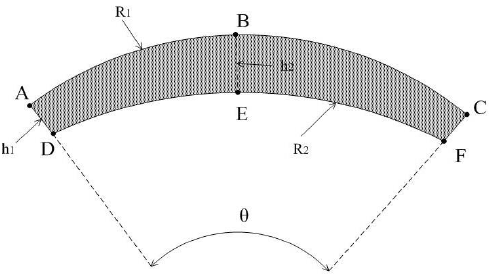
Figure 3. General pattern of one piece of permanent magnet (PM).